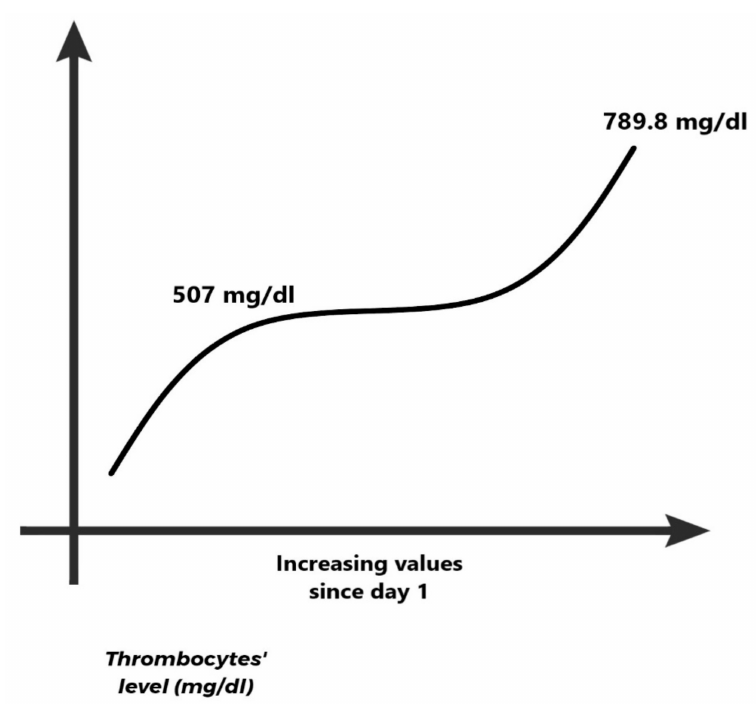
Figure 4. Changes in the thrombocyte